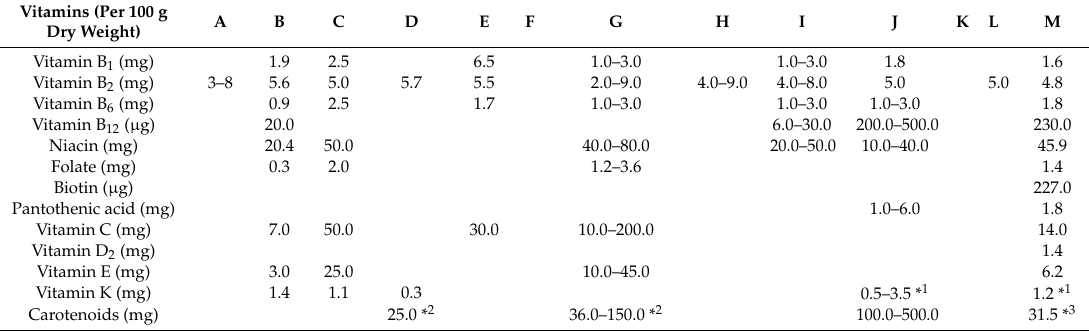
Table 3. Content of vitamins and related compounds in 13 commercially available Chlorella products.